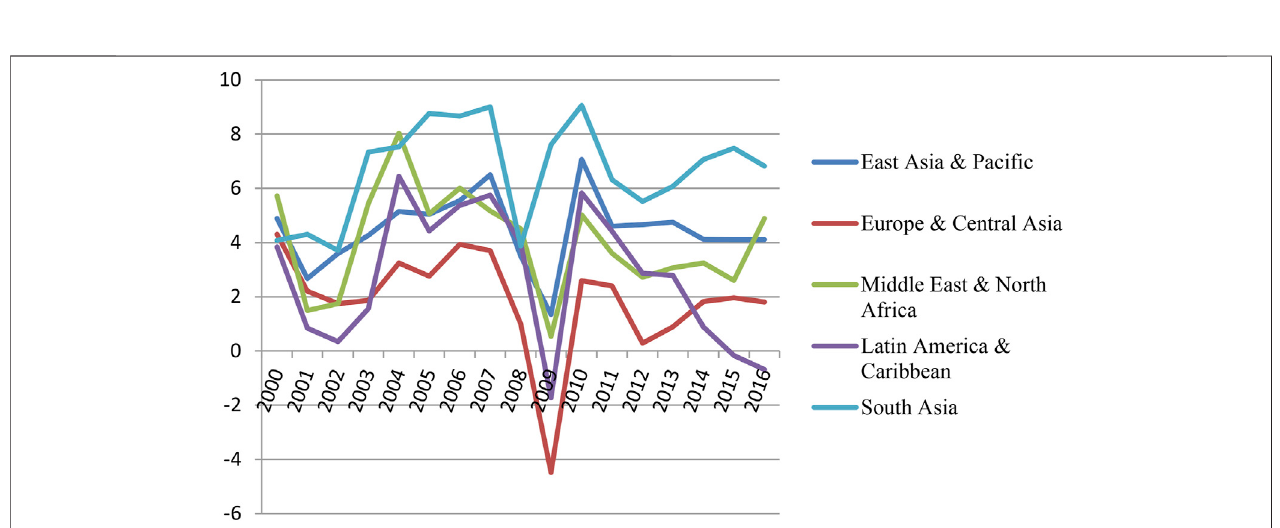
FIGURE 6 | GDP growth (annual %) in different regions except SSA. Source: World Development Indicator (2016).